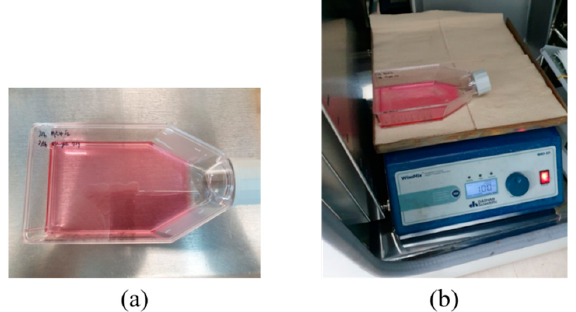
Figure 3. Shear stress test: ( a ) T flask containing MSCs, ( b ) digital shaker for shear stress.